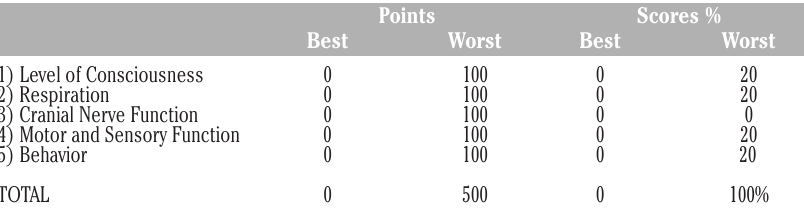
Figure 3. Neurological scoring system. Neurological deficit scoring carried out as per pro- tocol, using modifications of the methods of Nemoto, et al. and Grisvold, et al . Clinical